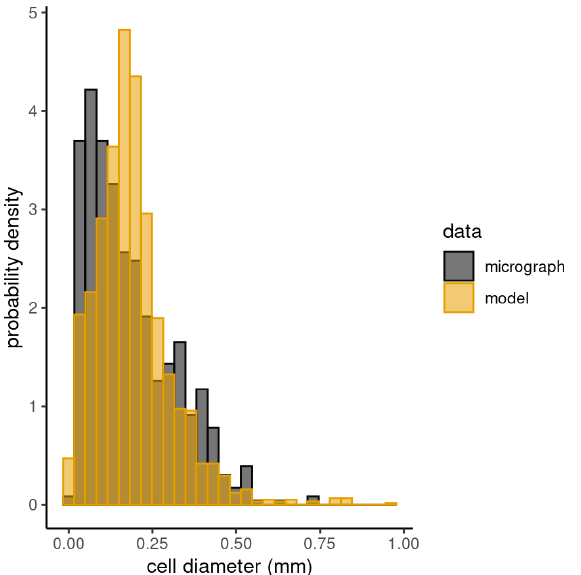
Figure 11. Histograms of maximal Feret diameters measured in the micrographs of the Inconel-617 and in 2D sections of realizations of the fitted Laguerre tessellation model with (cv s = 3.5 and 2000 cells)